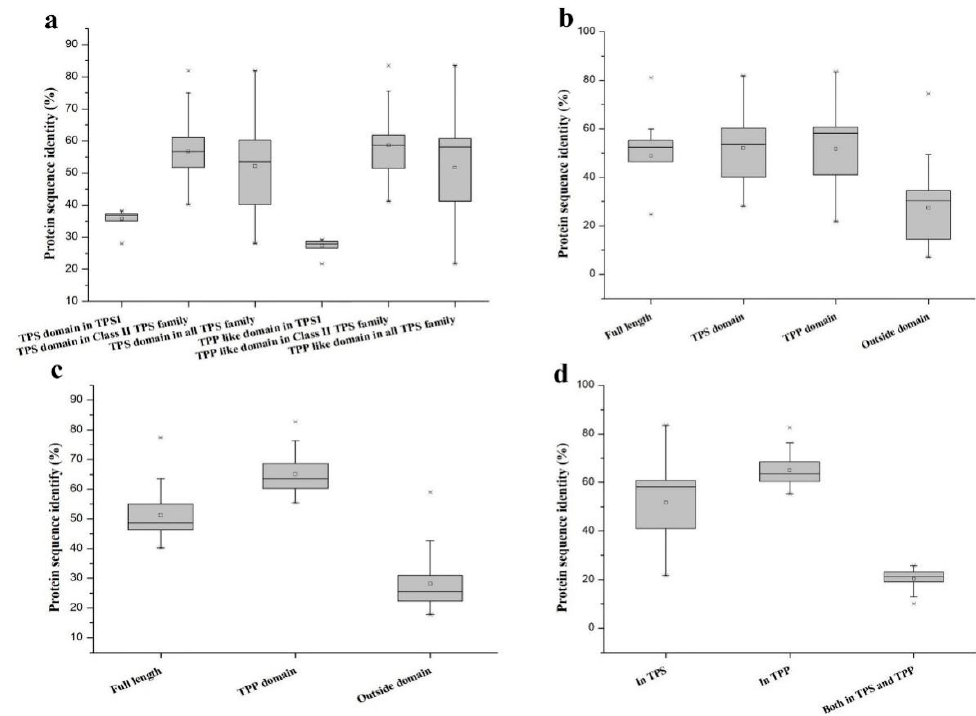
Figure 2. Pairwise sequence identities for different regions of the B. distachyon TPS and TPP proteins. ( a ) Pairwise sequence identities of the TPS and TPP domains in BdTPS. ( b ) Comparison of the TPS domain, TPP domain, protein sequence, and sequence outside the domain in BdTPS. ( c ) Comparison of the TPP domain, full-length protein sequence, and sequence outside the domain in BdTPP. ( d ) Comparison of the TPP domains in BdTPS and BdTPP.